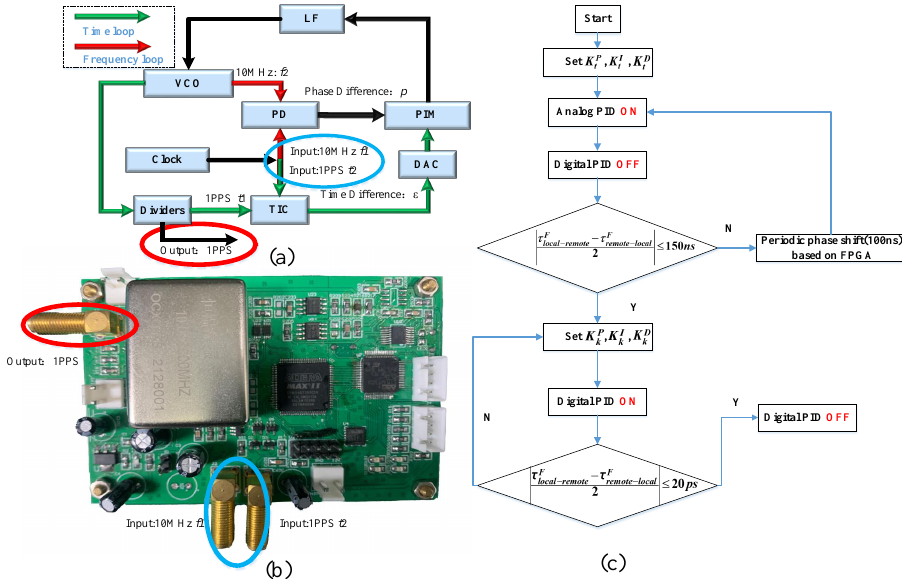
Figure 2. ( a ) Block diagram of the TF-PLL system; ( b ) Delay compensation system on a PC board. ( c ) Flowchart of the analog-digital hybrid PID control